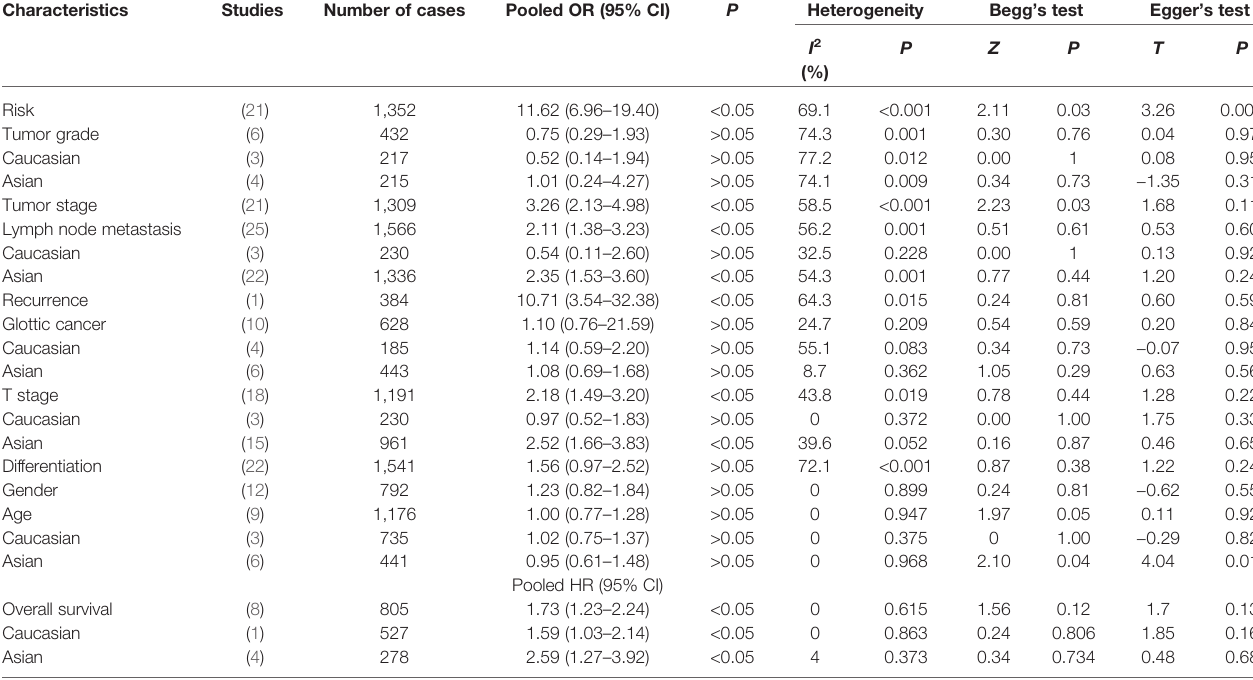
FIGURE 2 | Forest plots of the associations of COX-2 overexpression with clinical features of laryngeal cancer. (A) Tumor stage for laryngeal cancer. (B) Lymph node metastasis for laryngeal cancer. (C) Recurrence for laryngeal cancer. (D) T stage for laryngeal cancer. OR, odds ratio; CI, con fi dence interval. TABLE 3 | Meta-analysis results for COX-2 overexpression in risk, clinical features, and overall survival of laryngeal cancer patients.